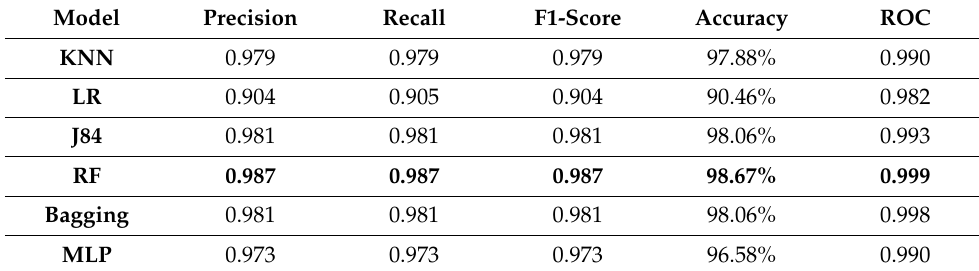
Table 9. Multiclass experiment results after features selection.